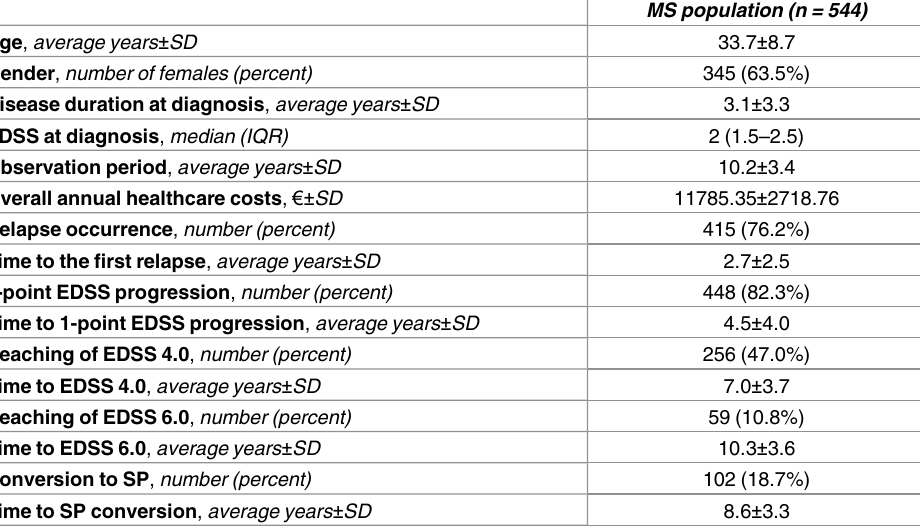
Table 1. Demographic features, clinical findings and healthcare costs. Demographic features, clinical findingsand annualhealthcarecosts for DMT administration and